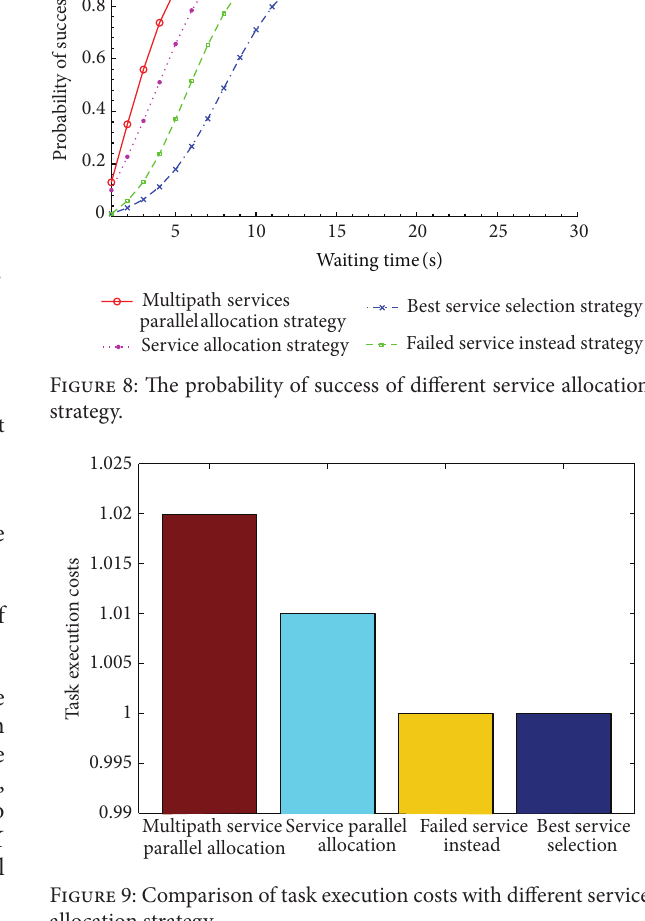
Figure 9: Comparison of task execution costs with different service allocation